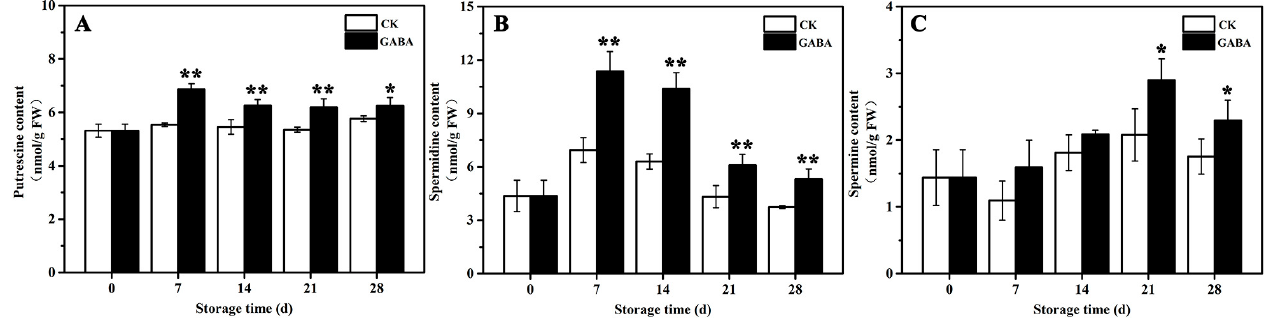
Figure 2. Change in ( A ) putrescine, ( B ) spermidine, and ( C ) spermine in peach fruit induced by GABA. All data are expressed as means ± standard errors (SE). Asterisks (*) indicate significant differences between the GABA and CK groups. Unpaired Student’s t -test; (*) p < 0.05, (**) p < 0.01. PpADC , PpODC , and PpPAO are key enzyme genes in PAs metabolism in peach fruit.